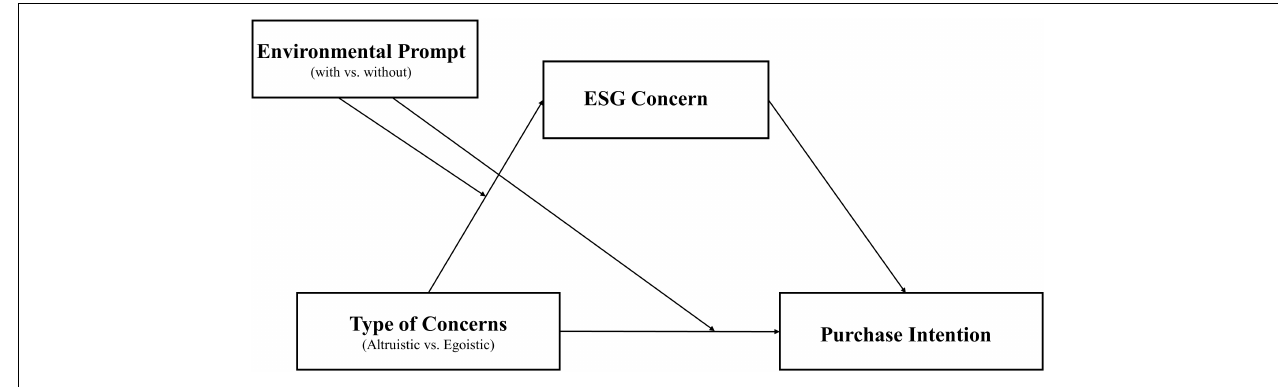
FIGURE 1 | Conceptual framework.